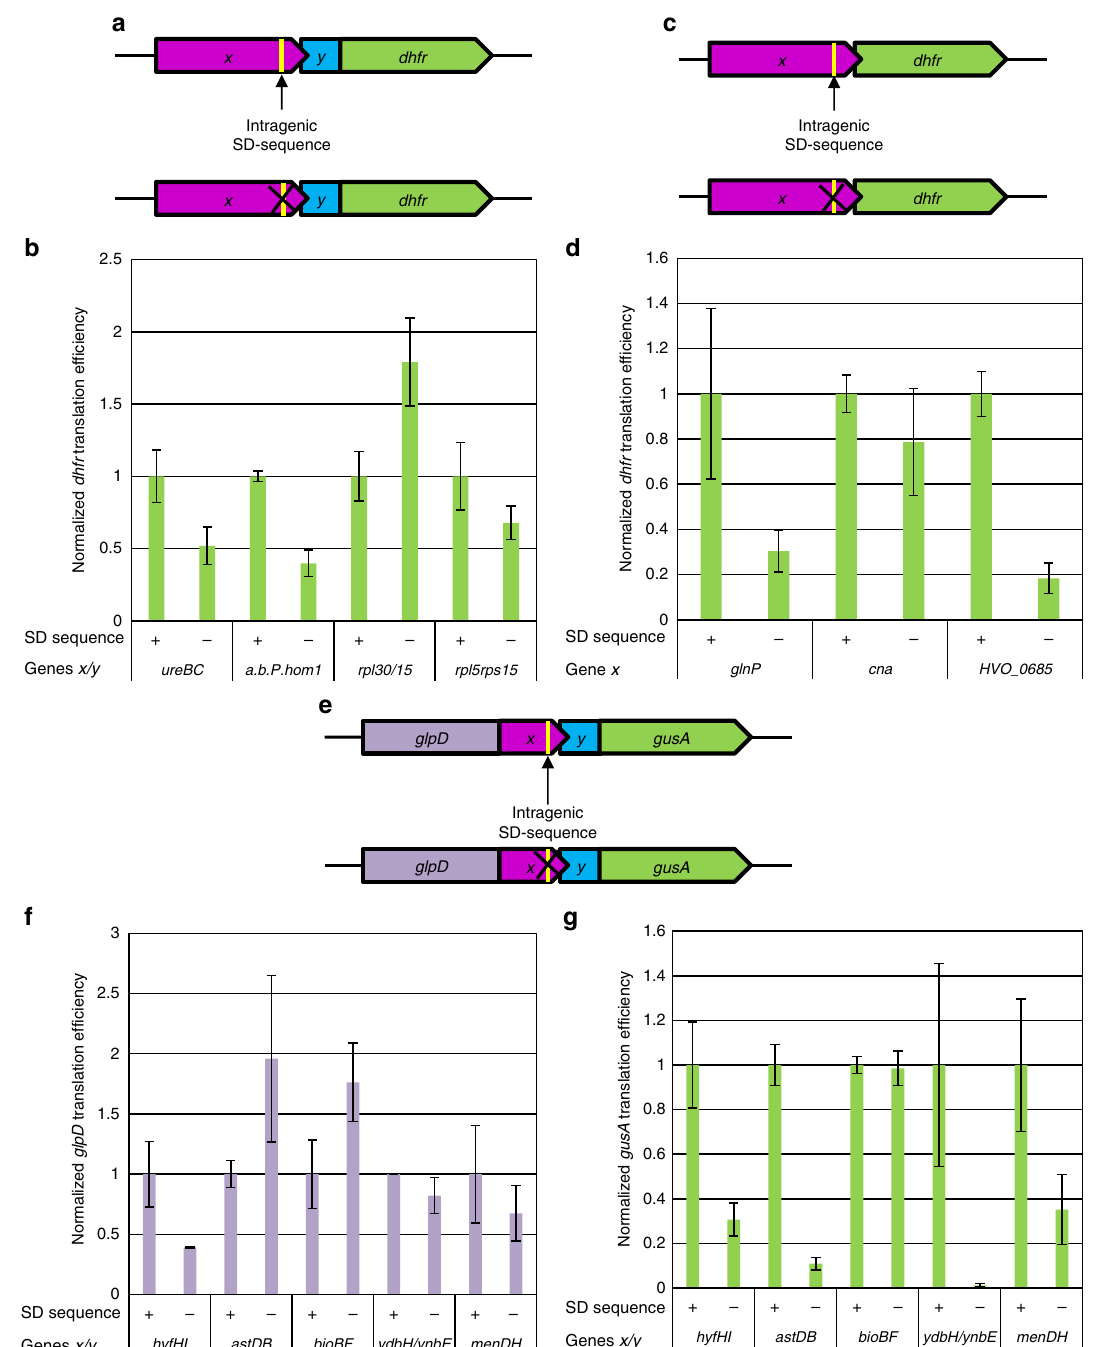
Fig. 5 The importance of the SD motif for termination-reinitiation. a Schematic overview of the constructs for H. volcanii . The native overlapping gene pairs are shown in magenta and blue, the dhfr reporter gene is shown in green. The intragenic SD motif is indicated by a yellow bar, which is crossed in the SD mutants. b Normalized translational ef fi ciencies of the native gene pairs containing ( + ) or lacking ( − ) a SD motif. The names of the gene pairs are shown at the bottom. Average results of three biological replicates and their standard deviations are shown. Source data are provided as Source Data fi le. c Schematic overview of the constructs for H. volcanii . The native upstream gene is shown in magenta, the dhfr reporter gene is shown in green. The intragenic SD motif is indicated by a yellow bar, which is crossed in the SD mutants. d Normalized translational ef fi ciencies of the containing ( + ) or lacking ( − ) a SD motif. The names of the genes are shown at the bottom. Average results of three biological replicates and their standard deviations are shown. Source data are provided as Source Data fi le. e Schematic overview of the constructs for E. coli . The native overlapping gene pairs are shown in magenta and blue, the glpD reporter gene is shown in purple, the dhfr reporter gene is shown in green. The intragenic SD motif is indicated by a yellow bar, which is crossed in the SD mutants. f Normalized glpD translational ef fi ciencies of the native gene pairs with ( + ) or without ( − ) a SD motif. The names of the gene pairs are shown at the bottom. Average results of three biological replicates and their standard deviations are shown. Source data are provided as Source Data fi le. g Normalized gusA translational ef fi ciencies of the native gene pairs with ( + ) or without ( − ) a SD motif. The names of the gene pairs are shown at the bottom. Average results of three biological replicates and their standard deviations are shown. Source data are provided as Source Data fi